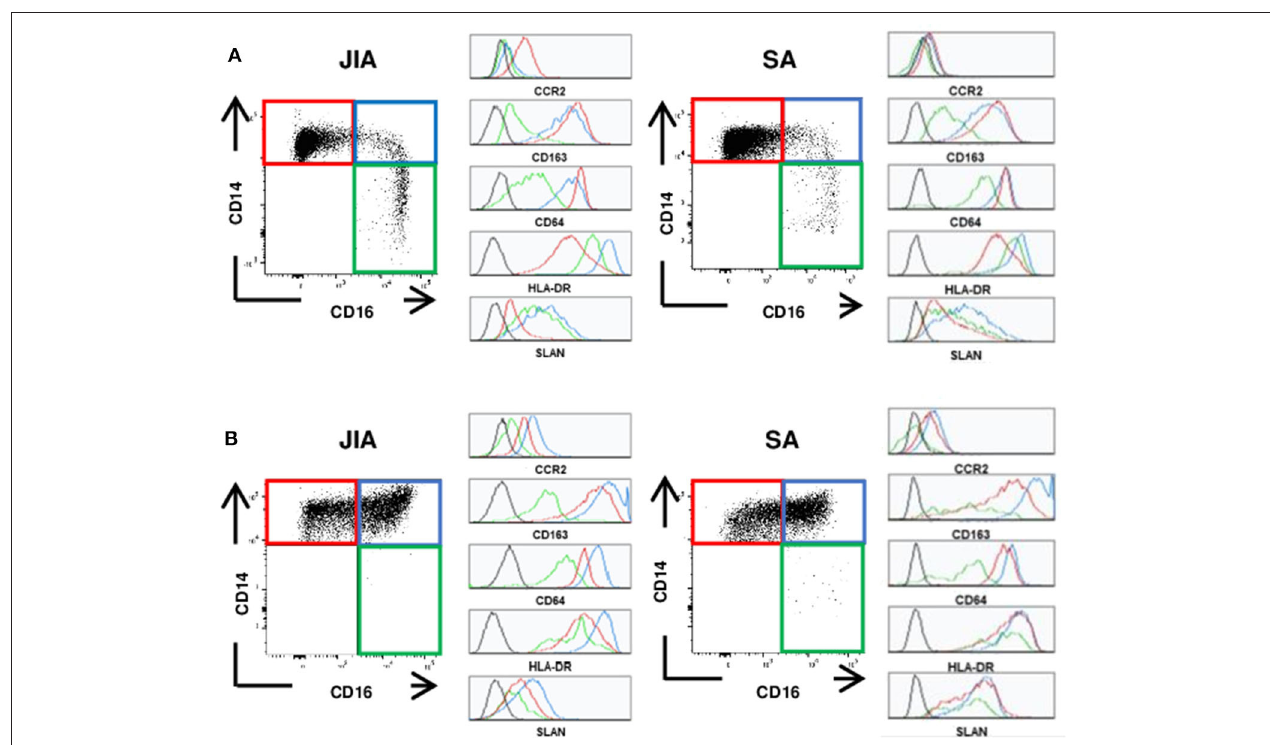
FIGURE 1 | Representative staining of monocyte subsets. Representative dot plots of the classical (CD14 ++ CD16 − , red), intermediate (CD14 ++ CD16 + , blue) and non-classical (CD14 + CD16 ++ , green) monocytes and representative histograms for the various markers (CCR2, CD163, CD64, HLA-DR, and SLAN) on each